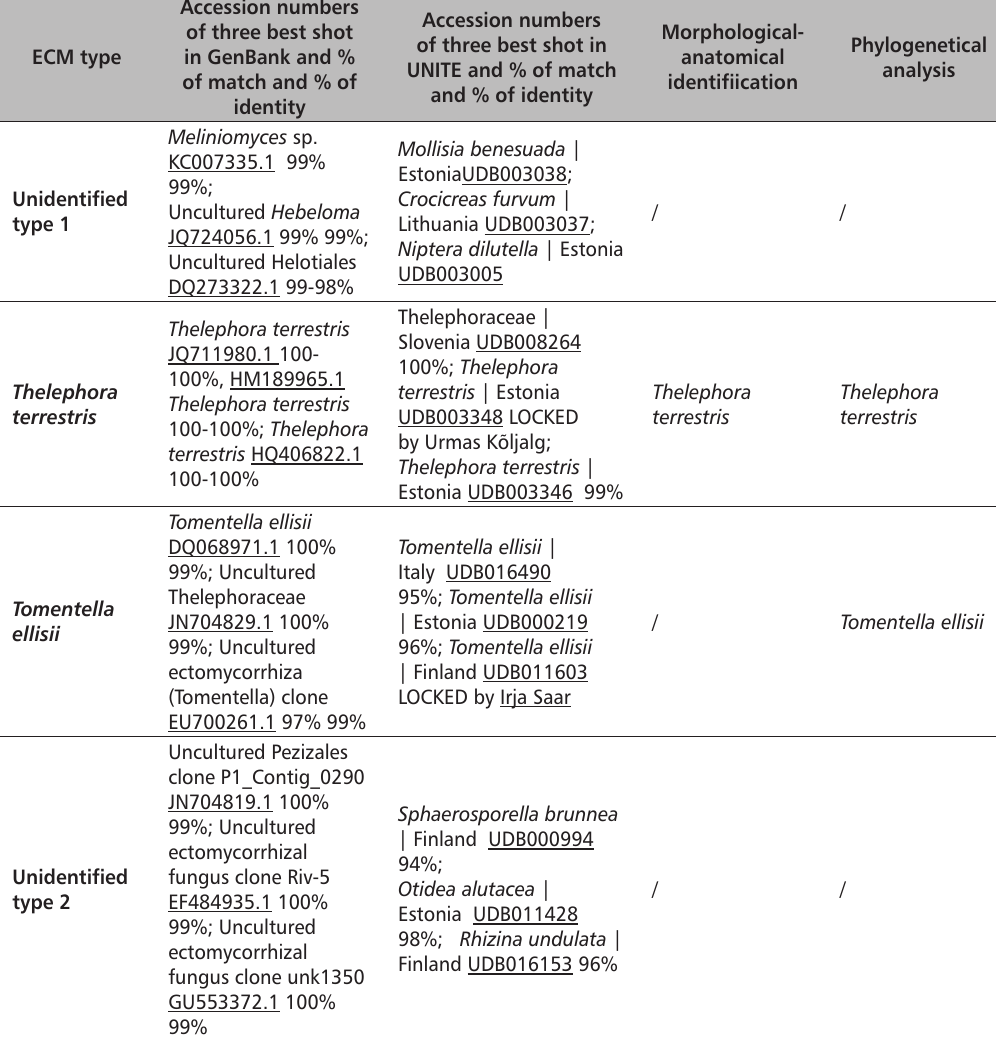
TABLE 4. Identified ectomycorrhizal fungi on the basis on the similarities with sequences given in the internet basis GenBank and UNITE and phylogenetic analyses